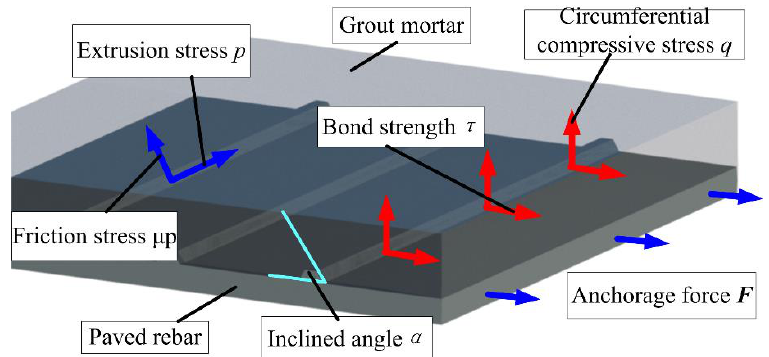
Figure 13. Stress distribution of the interaction surface.